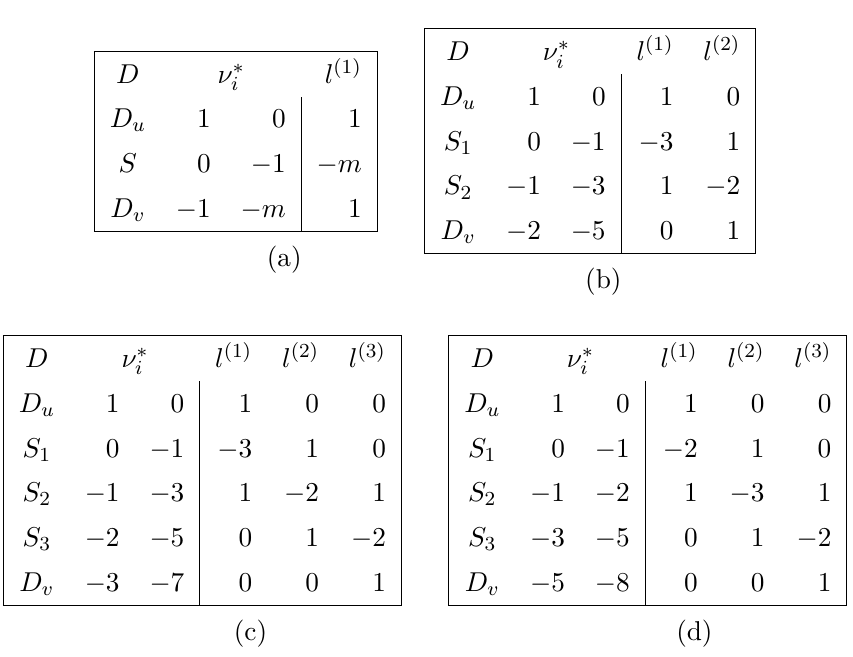
Table 4 . Toric realisation of non-Higgsable